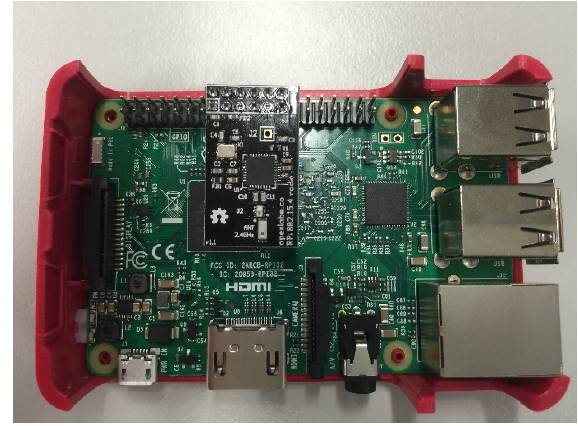
Figure 4. Raspberry Pi 3B+.